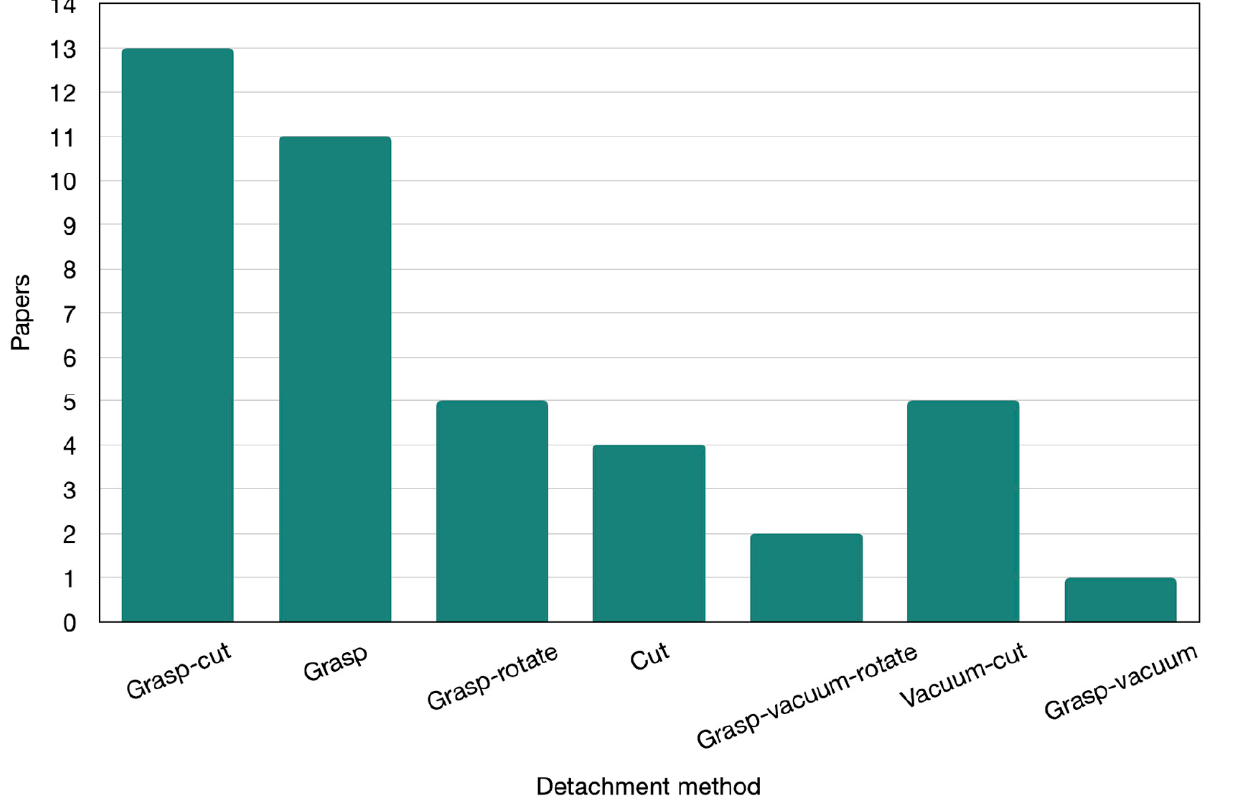
Figure 13. Distribution of papers in the referenced literature per detachment method.